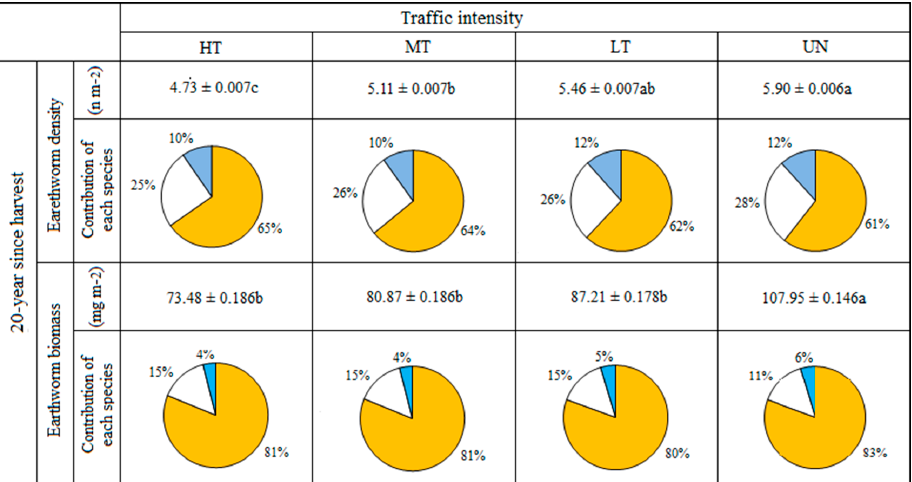
Figure 3. Mean values (±SD) of the earthworm density and biomass 20 years after harvesting under different traffic intensities (HT: skid trail with high traffic intensity, MT: skid trail with medium traffic intensity, LT: skid trail with low traffic intensity, and UN: undisturbed area). Contribution of epigeic (orange color), anecic (white color), and endogeic (blue color) earthworm density and biomass under different traffic intensities. Different letters in a row indicate significant differences among the total nematodes of the soil ( p < 0.05), based on Duncan’s multiple range tests. Soil nematode populations in the B-H-O litter treatment were significantly higher than in the B-H followed by B treatments, especially 20 years after harvest (Figure 4). The soil nematode population increased with increasing litter quality and time interval from harvest operations (Figure 4). However, with increasing traffic intensity from low to high, the population of soil nematodes decreased, so that their lowest population (166.78 in 100 g of soil) was observed in the high traffic intensity area 6 years after harvest operation (Table 2). Twenty years after harvest, the largest population of soil nematodes in the mixed beech litter treatment (313.65 in 100 g of soil) and low traffic intensity (216.33 in 100 g of soil) was less than in the undisturbed area (Figure 4; Table 2).